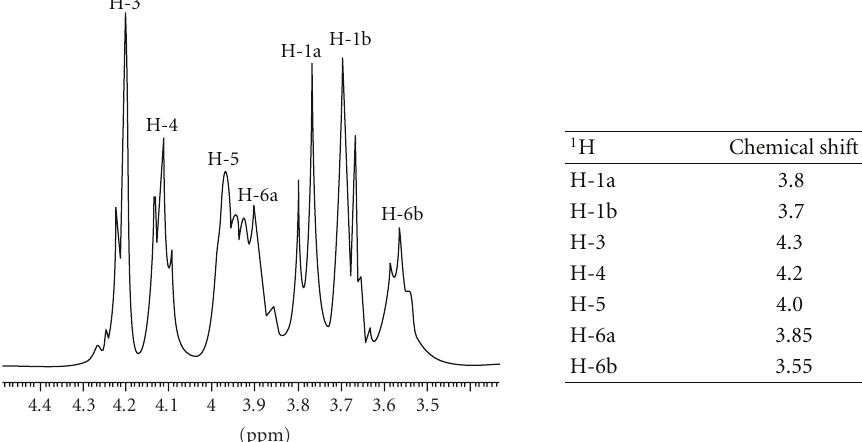
Figure 1: 1 H NMR spectra of levan from Zymomonas mobillis (ZAG-12L). The spectrum was recorded at 60 ◦ C for sample in D 2 O solution. The table shows the chemical shift.